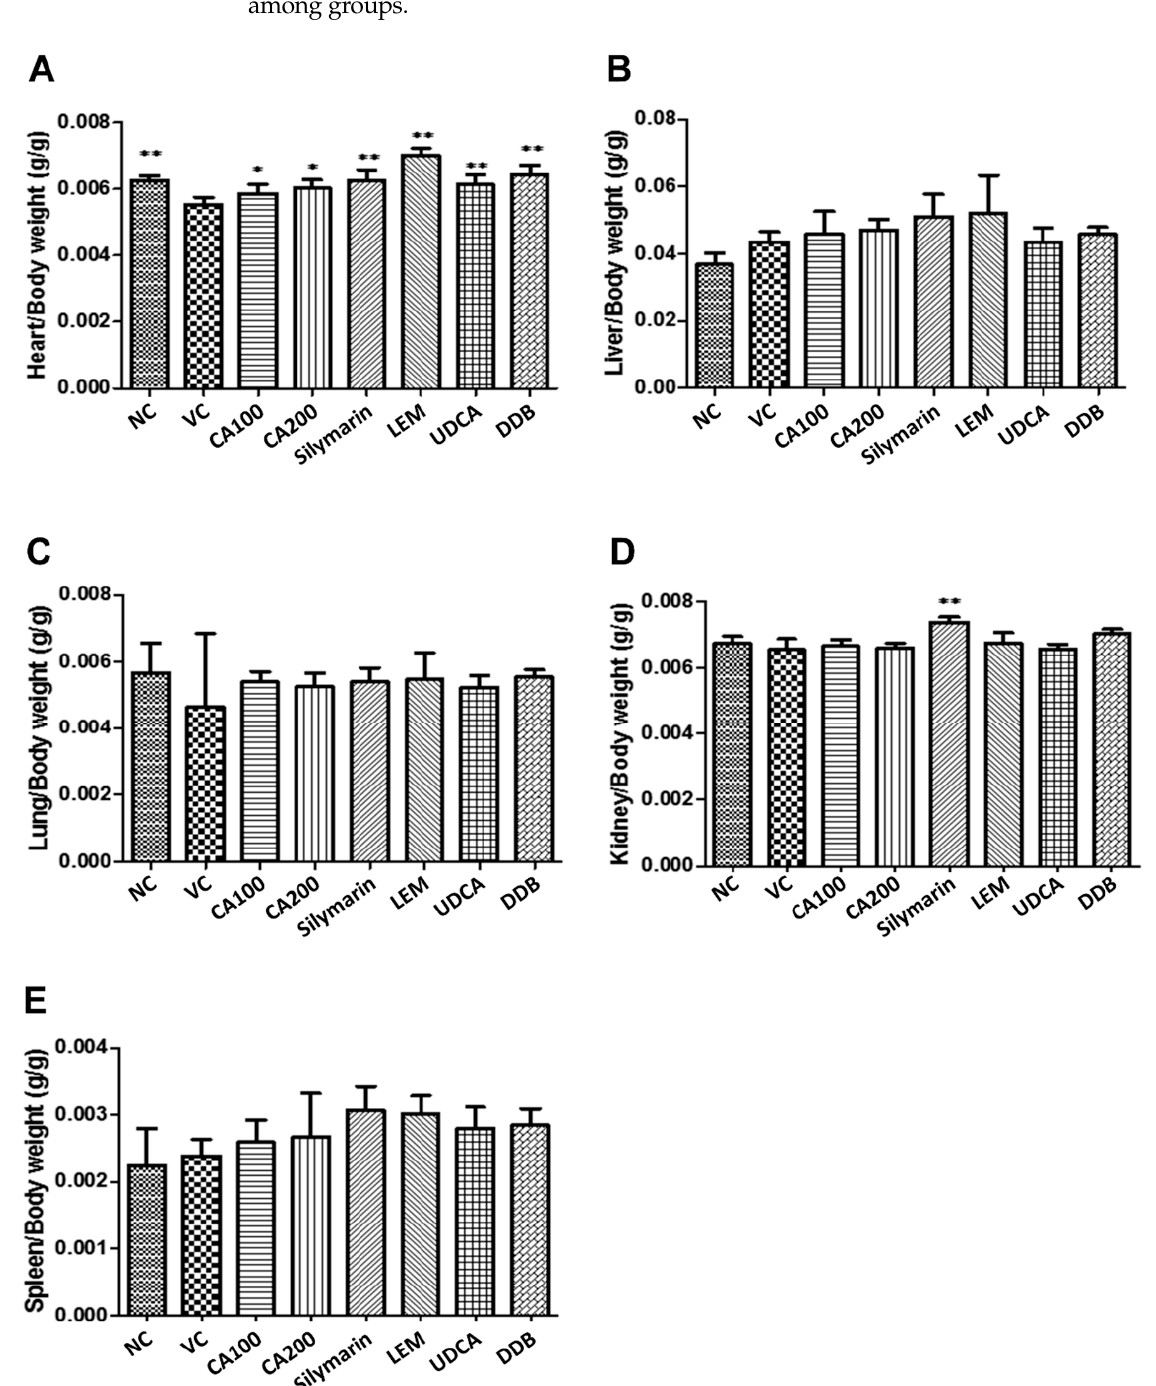
Figure 2. Effects of CA-HE50 on relative organ weight changes in LPS/D-Gal-induced ALF animal model. The weights of major organs collected from mice in each group were measured. ( A ) Heart; ( B ) liver; ( C ) lung; ( D ) spleen; ( E ) kidney. NC, normal control; VC, vehicle control; CA100, 100 mg/kg CA-HE50; CA200, 200 mg/kg CA-HE50; Silymarin, 100 mg/kg silymarin; LEM, 200 mg/kg LEM; UDCA, 25 mg/kg UDCA; DDB, 200 mg/kg DDB. Data are represented as mean ± SD (* p < 0.05 or ** p < 0.01 vs. vehicle control).